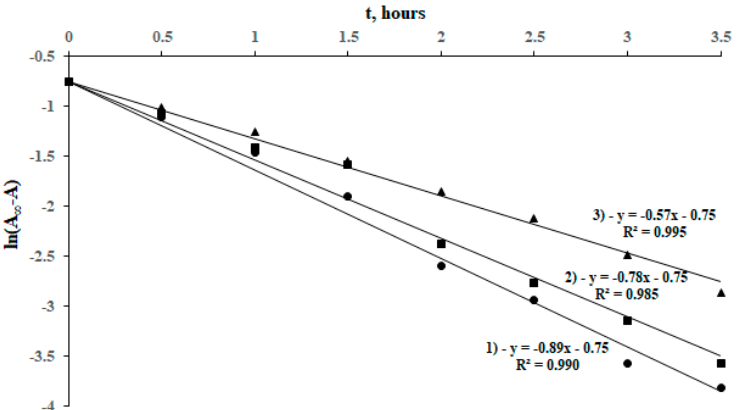
Figure 8. Linear dependence ln ( A ∞ − A ) vs. t , obtained for the process of release of doxorubicin at a temperature of 309 K through the dialysis membrane (500 MWCO): 1—from an aqueous solution; 2—from an aqueous solution of poly(N-vinyl-2-pyrrolidone); 3—from an aqueous solution of telechelic N-vinyl-2-pyrrolidone with terminal residues of thioacetic acid.